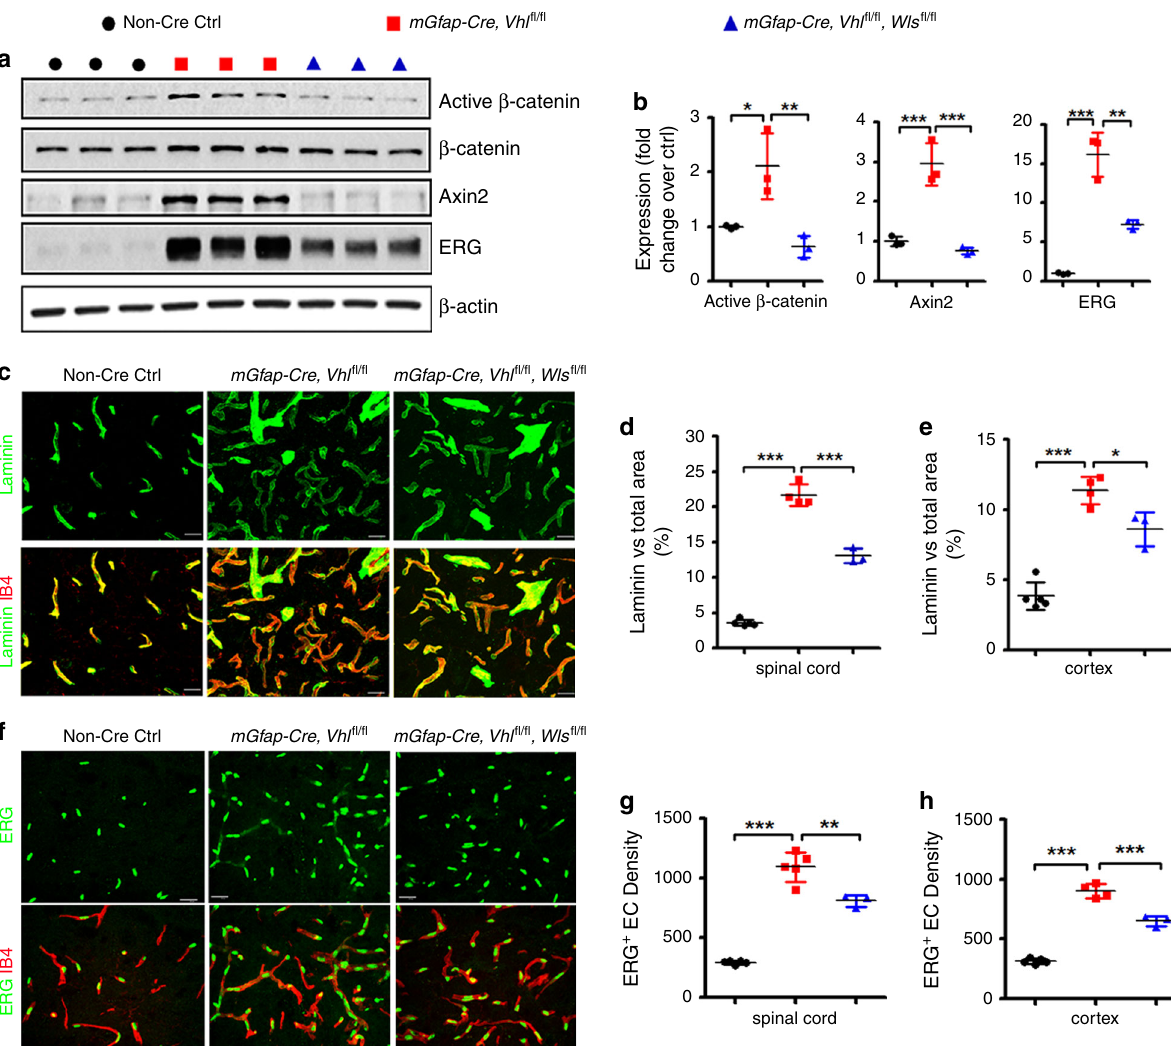
Fig. 9 Constitutively blocking Wnt secretion from astrocytes reduces HIF α -regulated angiogenesis in the early adult CNS. a , b Western blot ( a ) and quanti fi cation ( b ) of the active form of β -catenin, Wnt/ β -catenin target gene Axin2, EC-speci fi c nuclear protein ERG in the spinal cord at P30. One-way ANOVA followed by Tukey ’ s multiple comparisons, * P < 0.05, ** P < 0.01, *** P < 0.001. F (2,6) = 13.38, P = 0.0061 active β -catenin, F (2,6) = 41.26, P = 0.0003 Axin2, F (2,6) = 65.59, P < 0.0001 ERG. n = 3 each group. c Representative confocal images of Laminin and IB4 in the spinal cord at P30, scale bars